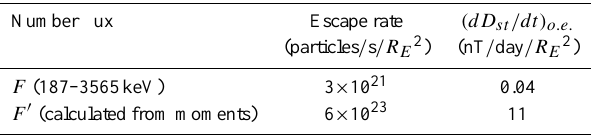
Table 1. Summary of Oxygen ion loss rate and the effect on D st (normalised by the unit escape area of 1 R E 2